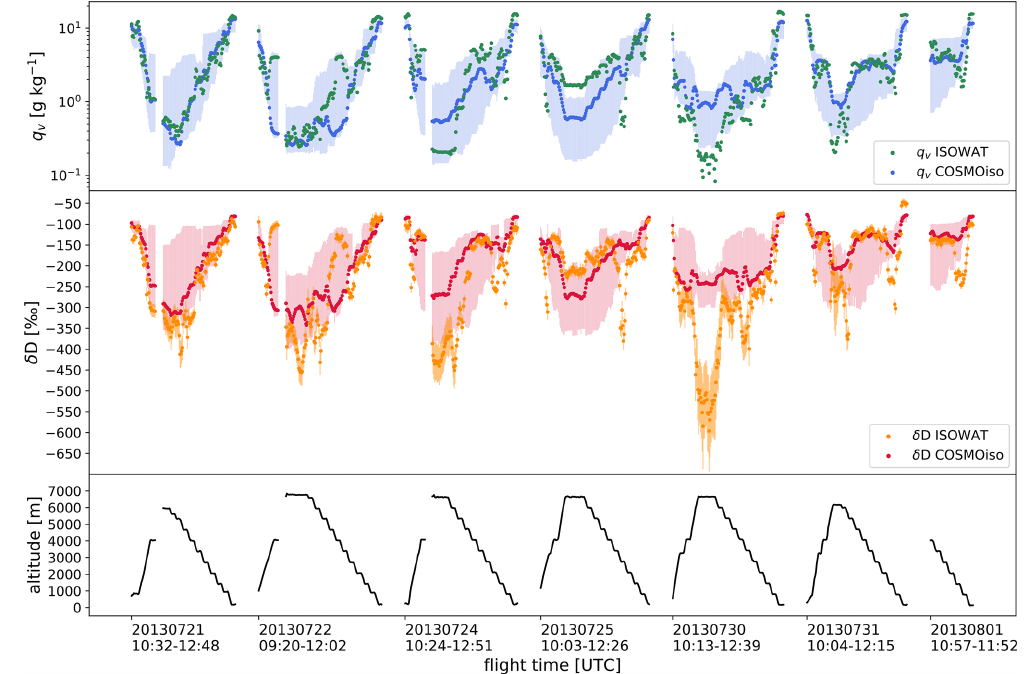
Figure 3. Comparison of COSMO iso and airborne in situ measurements (ISOWAT) of q v and δ D in water vapour from the MUSICA campaign in July and August 2013. The blue and red shadings represent the synoptic-scale variability of q v and δ D in COSMO iso by quantifying the minimum and maximum values sampled in a 5 ◦ × 5 ◦ box around each data point on the flight path (see Sect. 2.1.1). The orange shading indicates the ISOWAT measurement uncertainty of δ